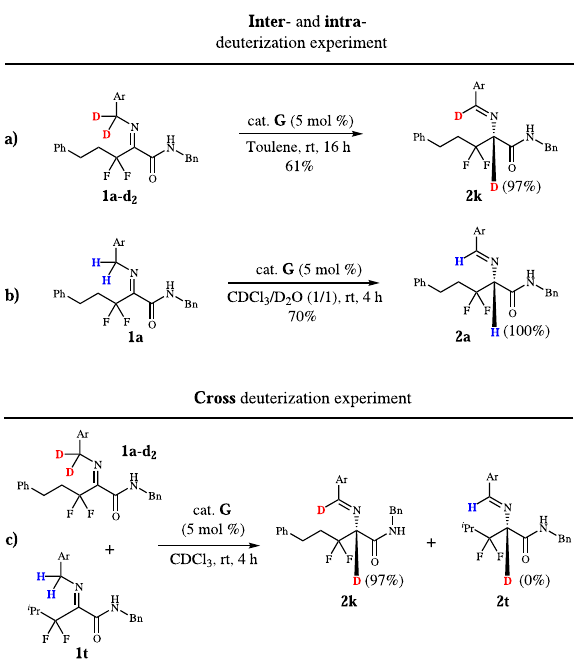
Fig. 4 Mechanistic studies. Deuterization and cross deuterization